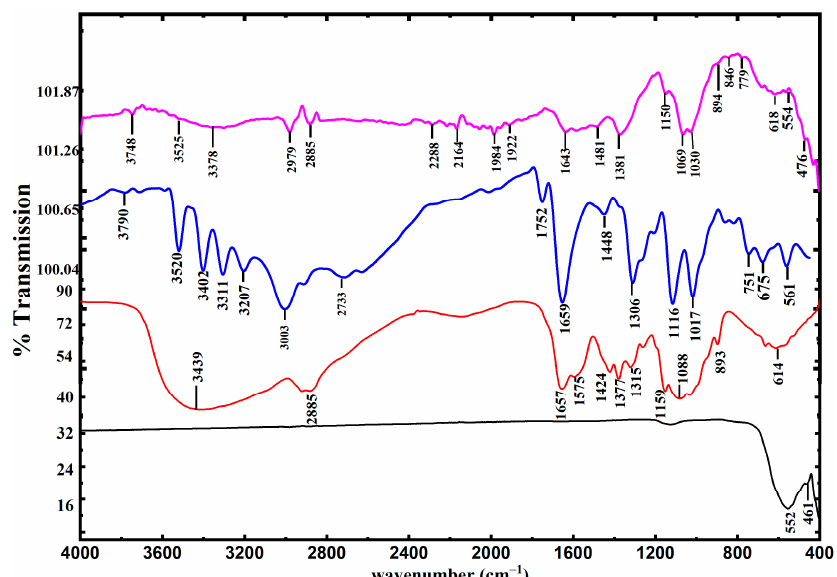
Figure 1. FTIR spectra of chitosan-ascorbic acid@NiFe 2 O 4 (magenta line) with its individual constituents NiFe 2 O 4 (black line), chitosan CT (red line), and ascorbic acid AS (blue line).